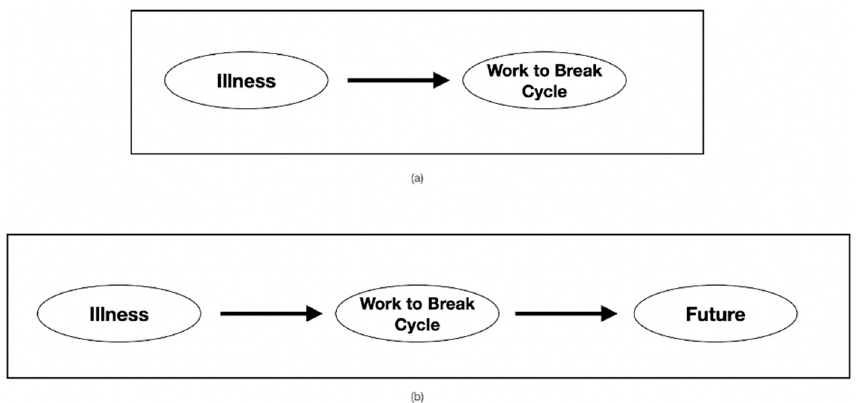
Figure 4. ( a ) Visual depiction connecting theme 1 (a prolonged illness) to theme 4 (fighting to carry the burden); ( b ) visual depiction of the connection between theme 1 and 4 with theme 5 (looking to the future).